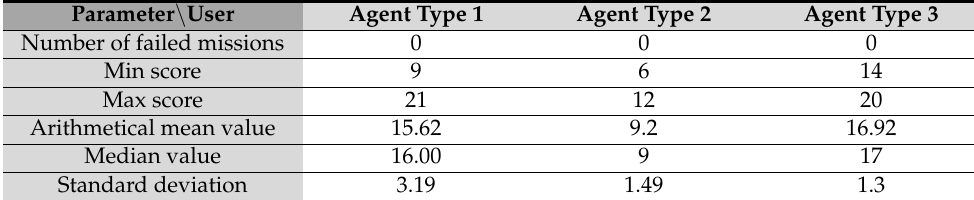
Table 1. Performance data for three agents in a static mode environment, based on the 50 simulation cycles.